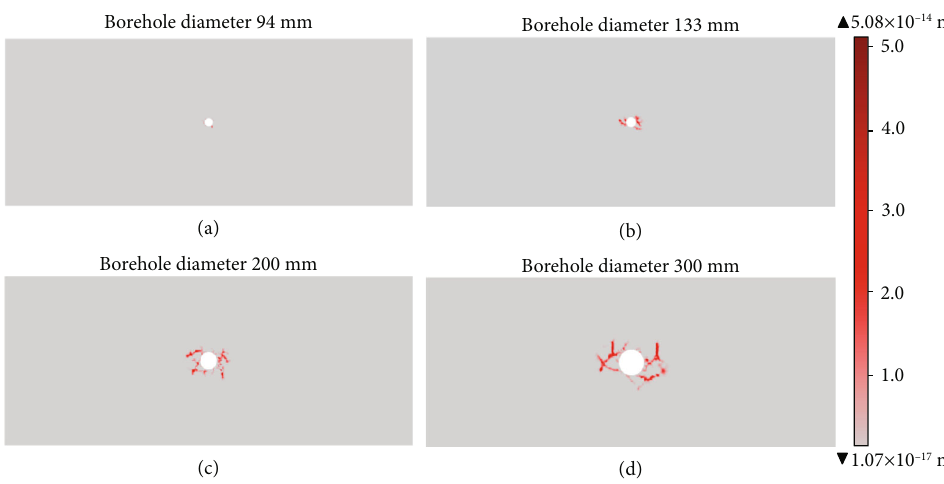
Figure 8: Distribution of permeability in soft coal seam with di ff erent borehole